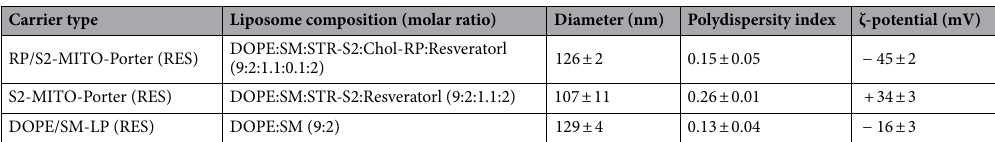
Table 1. Particle properties of the carriers encapsulating RES used in this study. Size, PDI, and ζ potential of each particles were measured. DOPE 1,2-dioleoyl- sn -glycerol-3-phosphatidyl ethanolamine, Chol-RP cholesteryl RP aptamer, SM sphingomyelin, STR-S2 stearylated S2 Peptide. S2 peptide sequence: (Dimethyl- Tyr)-( D -Arg)-(Phe)-(Lys)-(Dimethyl-Tyr)-( D -Arg)-(Phe)-(Lys)-NH 2 . RP aptamer sequence: 5 ′ -UCU CCC UGA GCU UCAGG-3 ′ . Data are represented as mean with S.D. (n = 7).